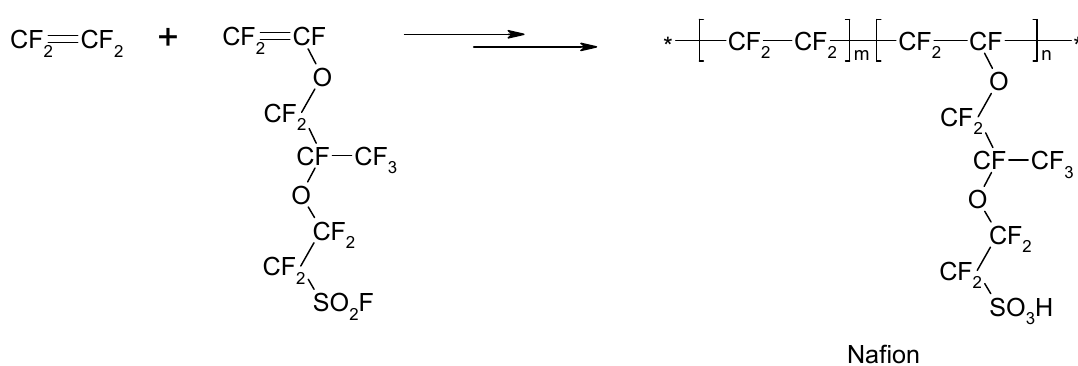
Figure 6. The preparation of